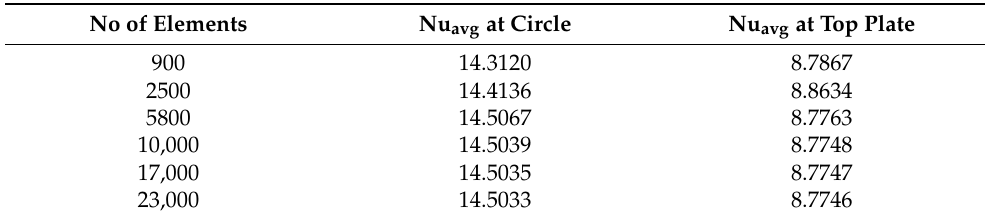
Figure 2. Mesh generation with 5362 non-uniform triangular elements. Table 3. Grid independency of the present solution showing Nu avg at different number of elements (Gr = 10 5 , Re = 100, Pr = 6.2, Ha = 50, α = 45 ◦ , β = 0).